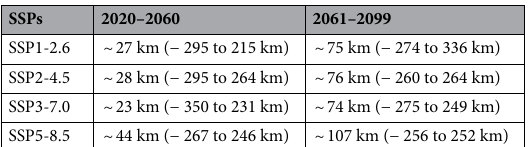
Table 2. Migration of the EASM northern boundary. The brackets denote the 20th and 80th percentiles of the individual models .